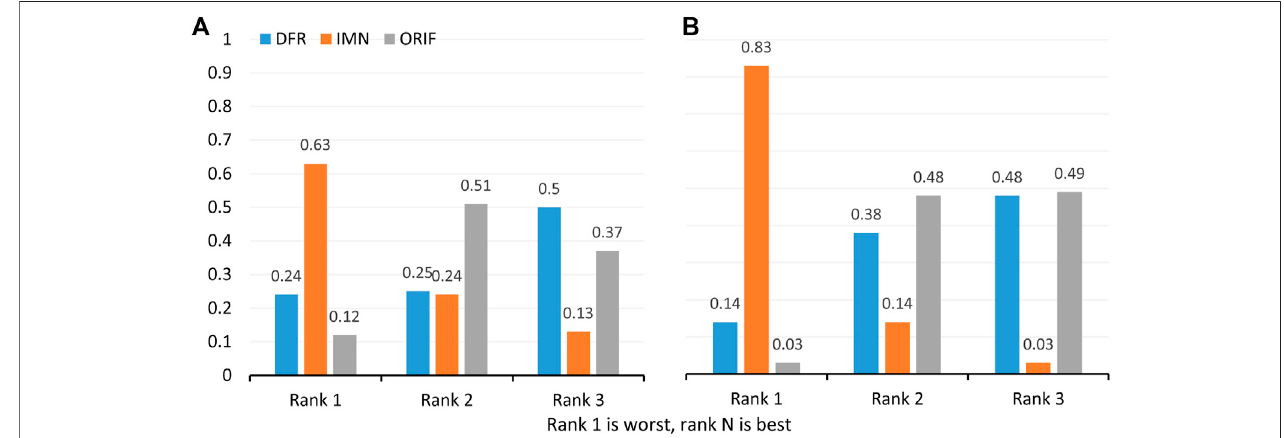
FIGURE 5 | Ranking probabilities of all targeted interventions in terms of major complications (A) and reoperation rate (B)